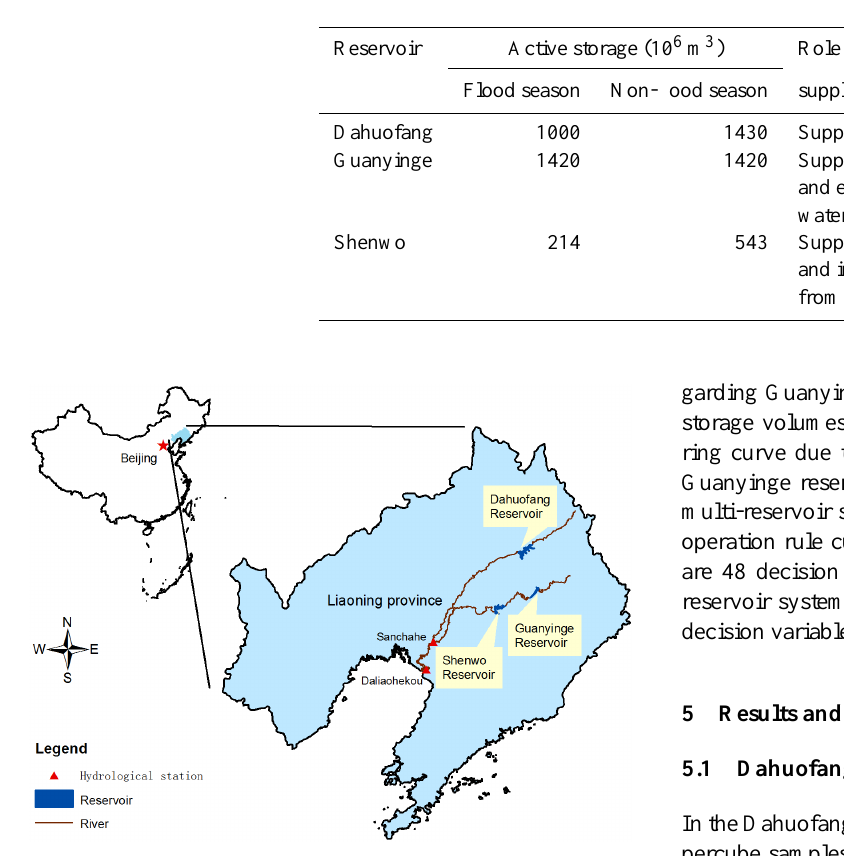
Figure 3. Layout of the inter-basin multi-reservoir